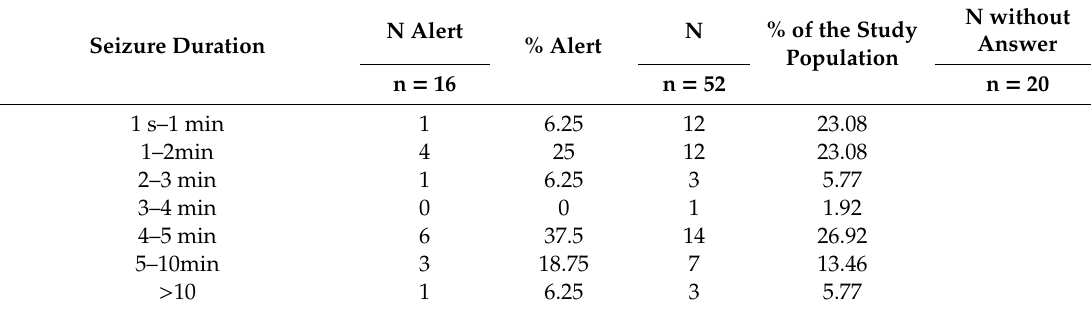
Table 2. Demographics of epilepsy in our study sample and specifically in the human population who reported alert behavior of their